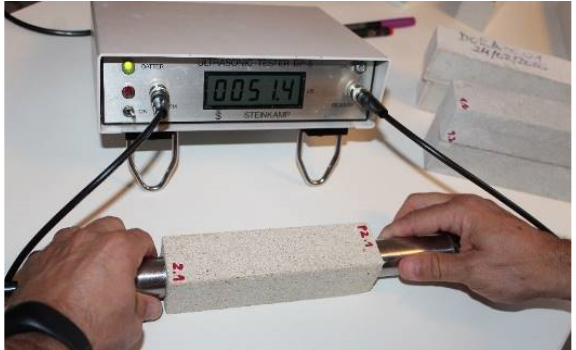
Figure 5. Sample P2.1 (Bateig Beige Hydra) subjected to direct ultrasonic testing.